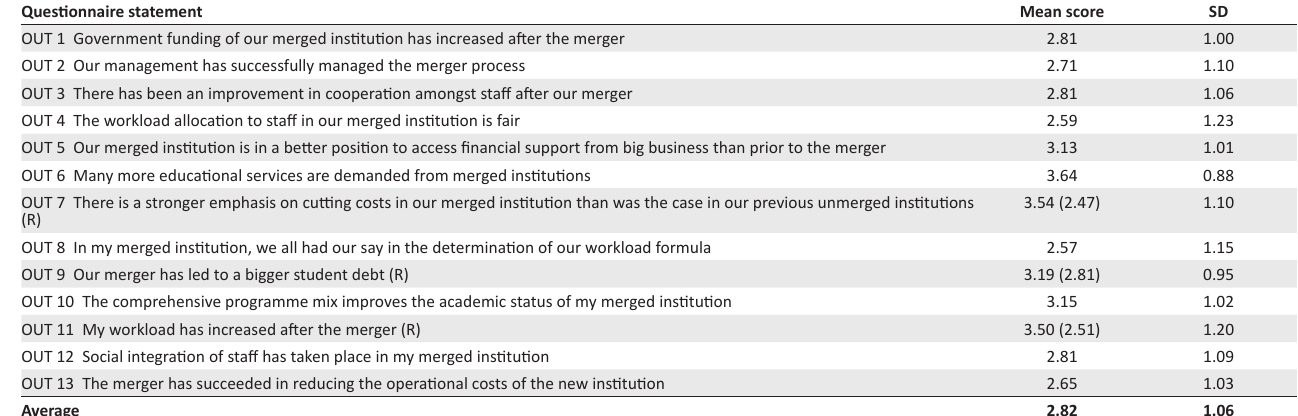
TABLE 6: Perceptions about merger outcomes: Descriptive statistics. Questionnaire statement